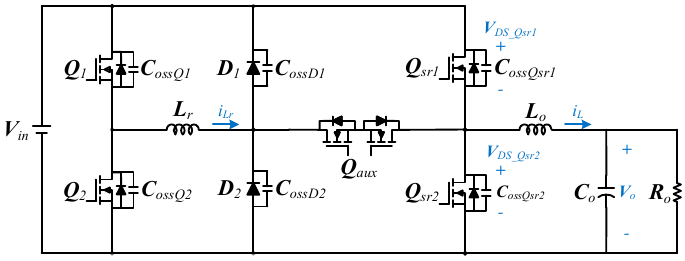
Figure 7. Bilateral zero-voltage switching (ZVS) synchronous rectified step-down converter.